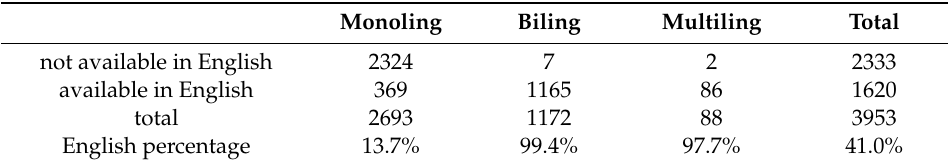
Table A24. English language availability